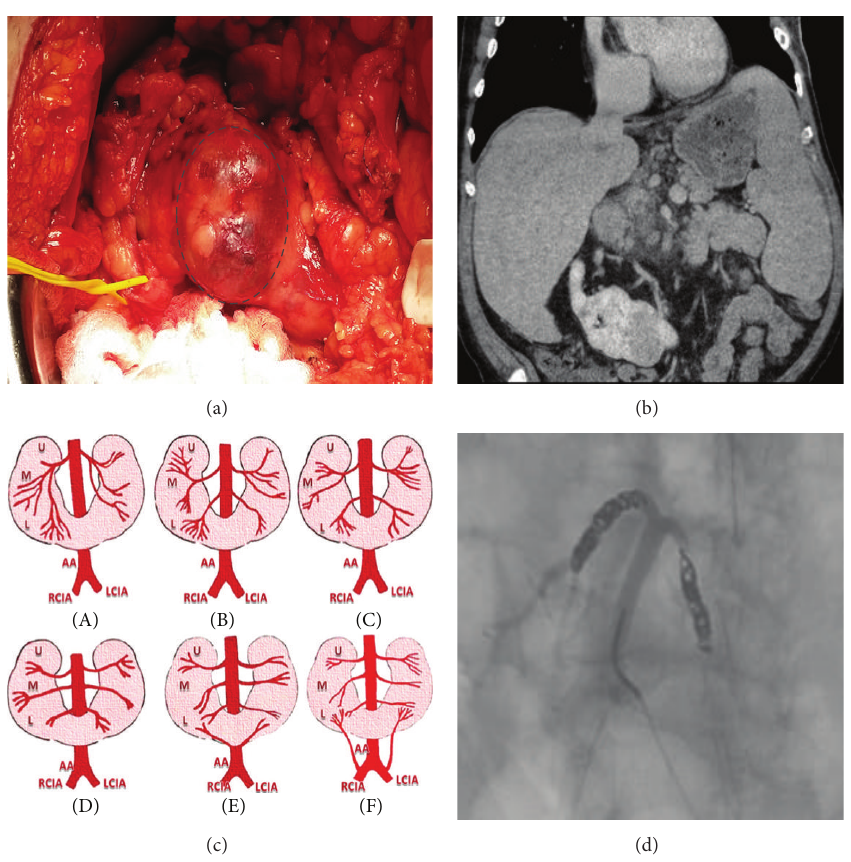
Figure 1: (a) Encircled intraoperative gross specimen of resected RCC containing isthmus. (b) Coronal CT image indicating RCC containing isthmus. (c) Catton of six major patterns of HSK vasculature. (d) Aberrant single infrarenal vascular supply of the isthmus of HSK with coils at the